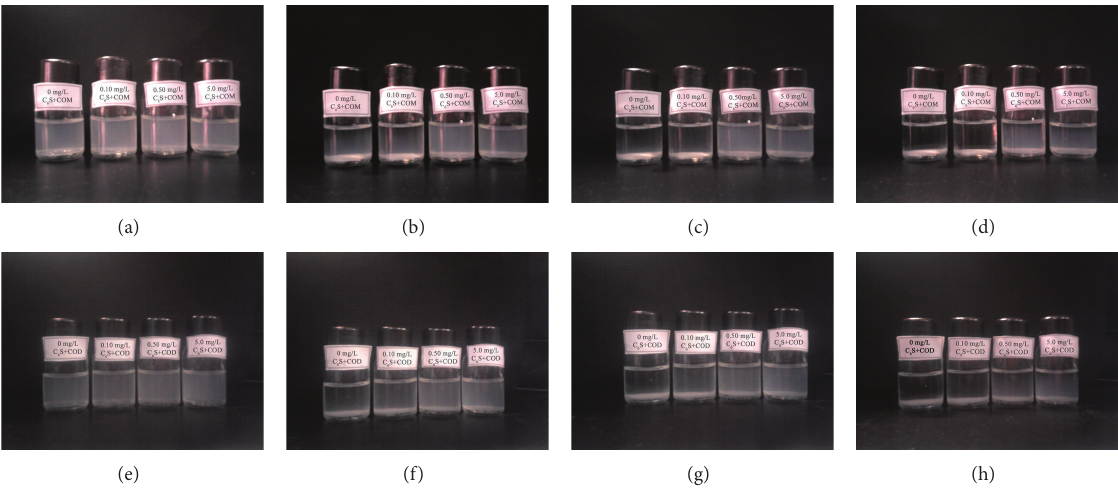
Figure 9: Photos showing sedimentation of the suspension of submicron COM and COD crystallites with placement time in presence of 0, 0.1, 0.5, and 5mg/L of C 6 S, respectively. (a)–(d) COM; (e)–(f) COD. (a) and (e) 0 h; (b) and (f) 2 h; (c) and (g) 4 h; (d) and (h)